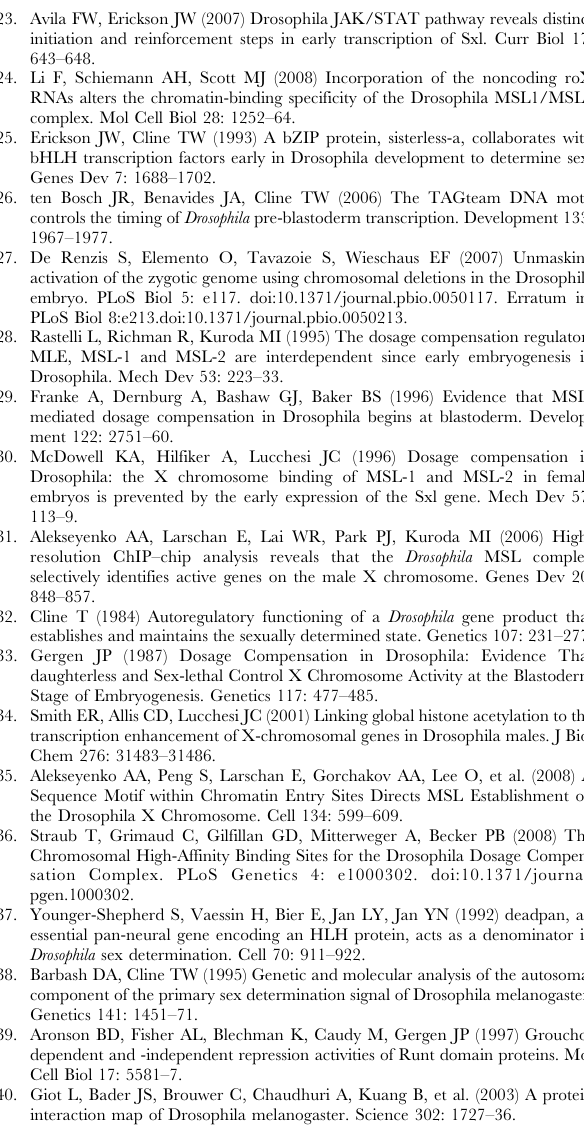
Figure S1 MSL-2 affects accumulation of sis-a mRNA. In situs of embryos using a sis-a probe shows early expression (cycles 9 and 10) to be slightly lower in embryos from homozygous msl-2 1 mothers. By cycle 12, however, the levels accumulated in embryos from msl-2 1 mothers were higher than wild